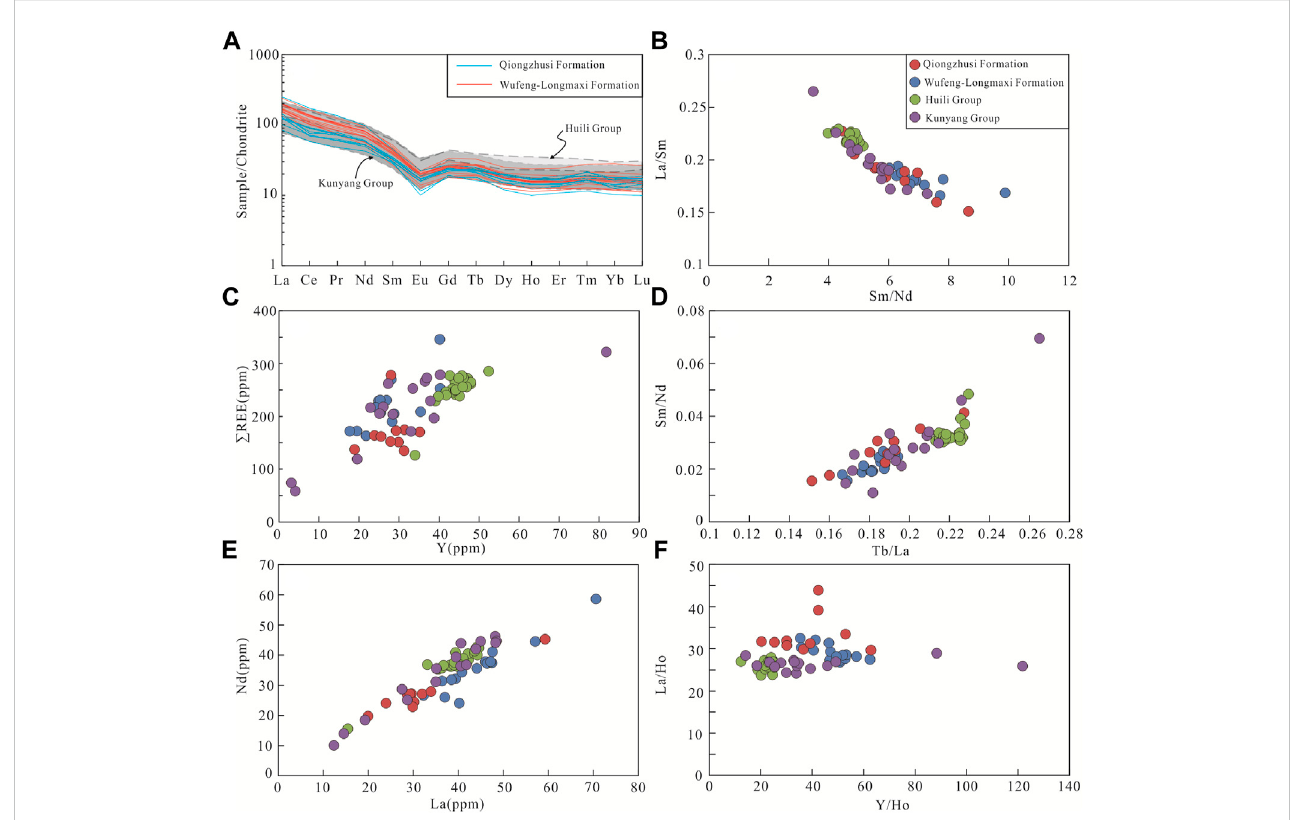
FIGURE 12 RareEarthelementcomparisonbetweentheQiongzhusiFormationandWufeng-LongmaxiFormationsourcerocksandthebasementrocksofKunyang groupandHuiligroup. (A) Chondrite-normalizedREEpatterns; (B) Yvs. (cid:1) REE; (C) Lavs.Nd; (D) Sm/Ndvs.La/Sm; (E) Tb/Lavs.Sm/Nd; (F) Y/Hovs.La/Ho.Data of source rocks are from Xia, 2016; Data of basement rocks are from Yin, 2015; Ji et al., 2016.